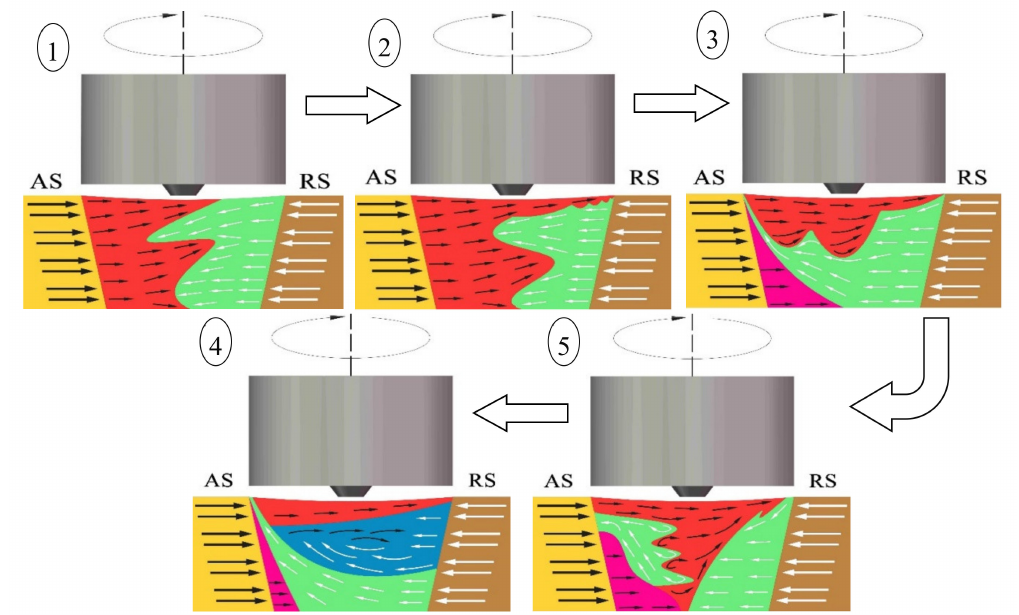
Figure 11. Model drawing of material flow on the